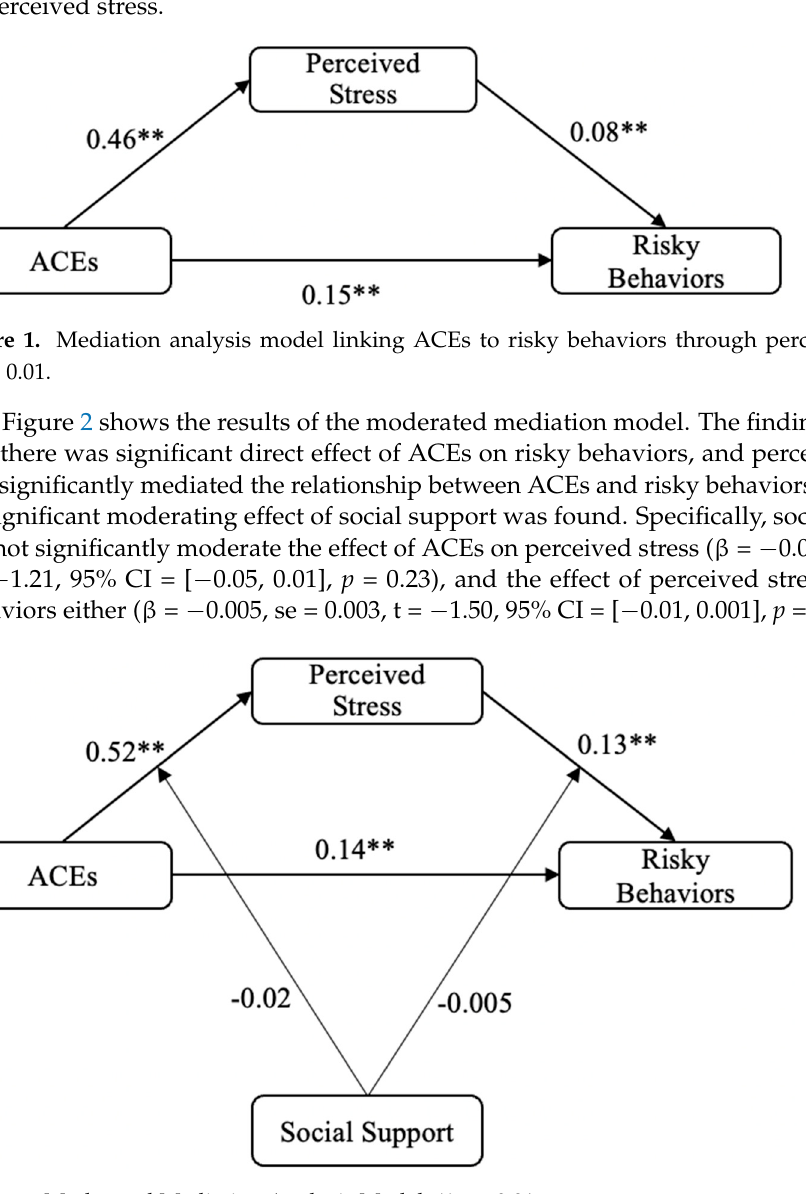
Figure 2. Moderated Mediation Analysis Model. ** p < 0.01.